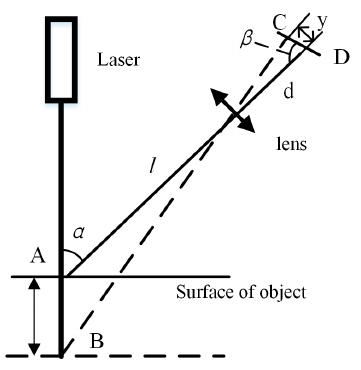
Figure 6. Principle of vertical type laser triangulation.